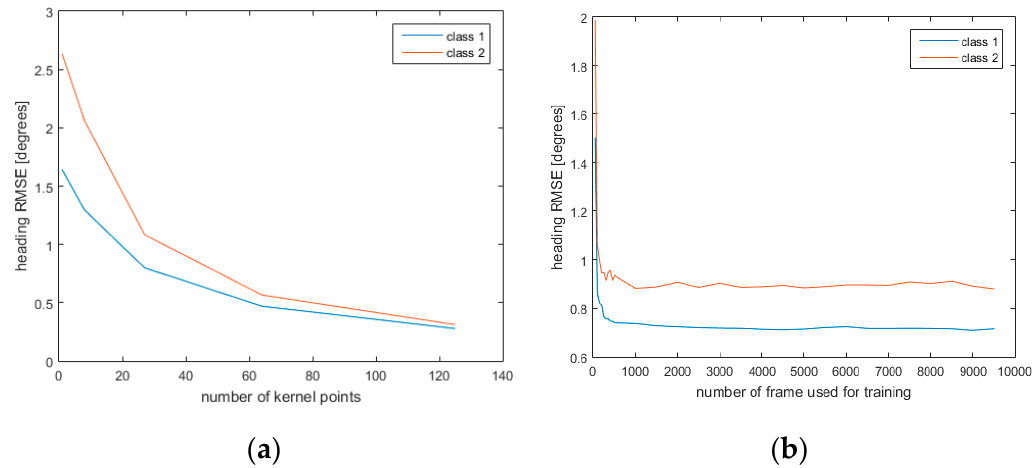
Figure 3. ( a ) Heading RMSE as a function of the number of kernel points used to interpolate the data in the TPS model. The number of frames used for training the algorithm was 7000. ( b ) Heading RMSE as a function of the number of frames used for training the algorithm. The number of kernel points was fixed at 27.